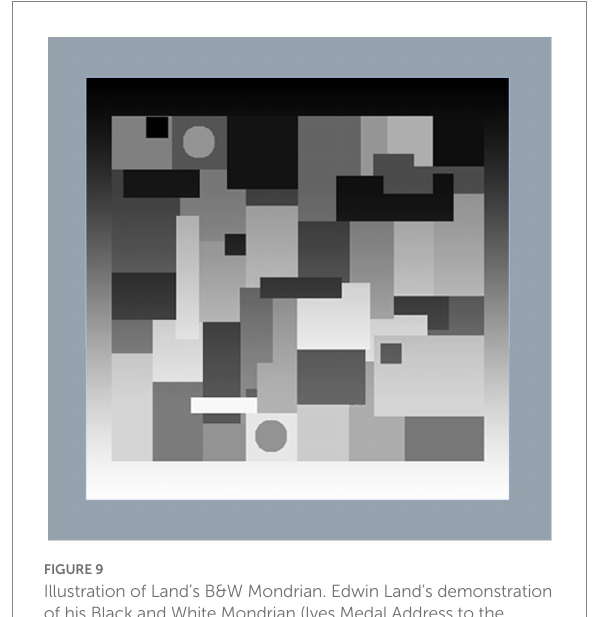
FIGURE 9 Illustration of Land’s B&W Mondrian. Edwin Land’s demonstration of his Black and White Mondrian (Ives Medal Address to the Optical Society of America in